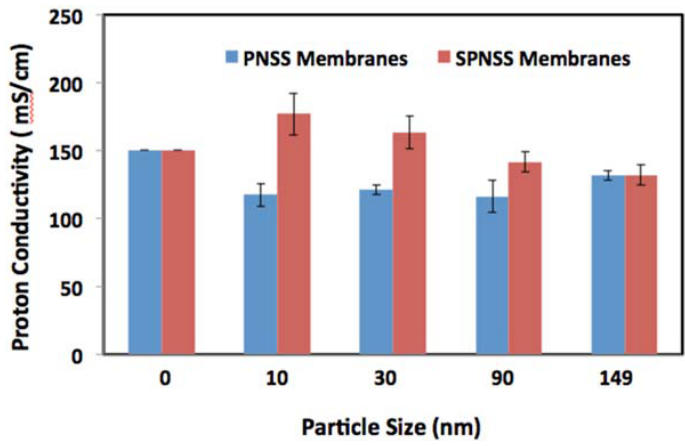
Figure 6. Comparison of the proton conductivity of SPNSS and PNSS nanocomposite membranes at 80 °C and 100% relative humidity. 80 ˝ C and 100% relative